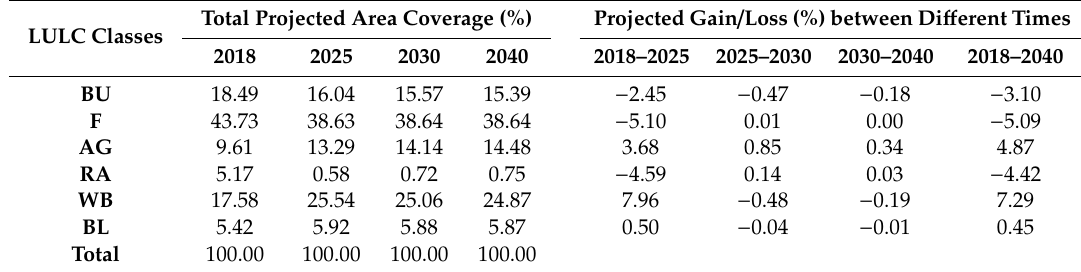
Table 7. Gain/loss (%) estimation between different times based on LULC total area coverage (%) from 2018 to 2040. LULC Table 7. Gain / loss (%) estimation between di ff erent times based on LULC total area coverage (%) from 2018 to 2040.